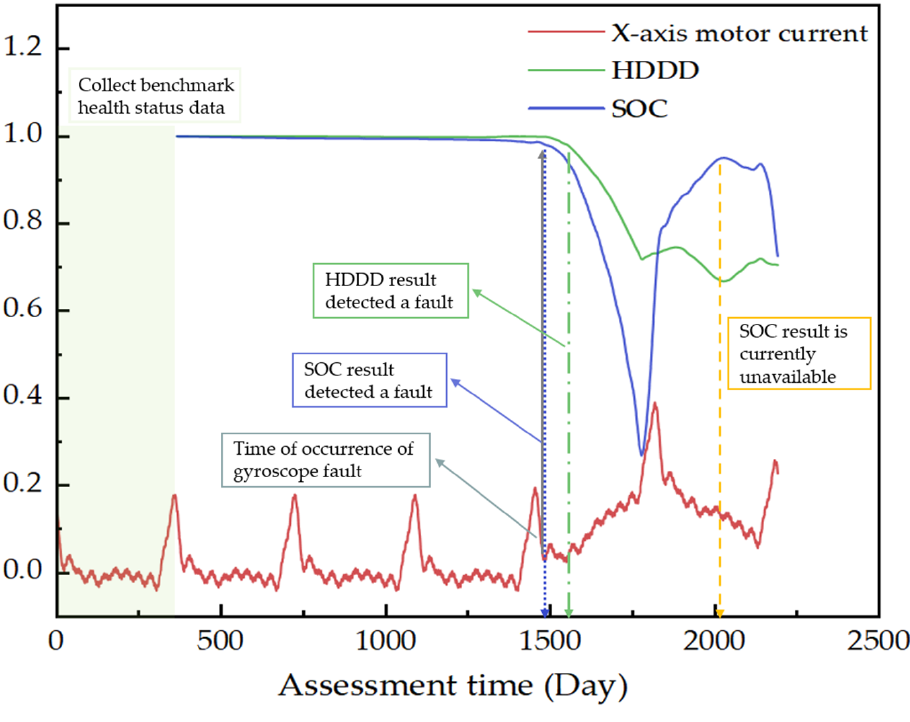
Figure 4. Single-parameter health state description method.